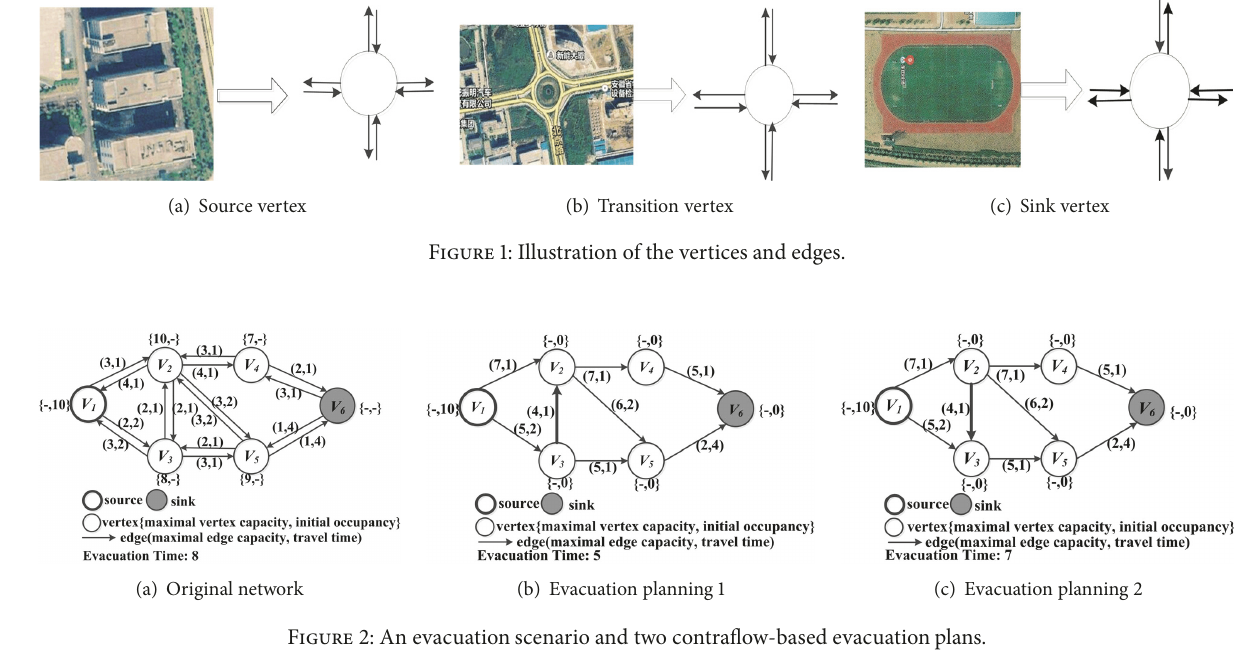
Figure 2: An evacuation scenario and two contraflow-based evacuation